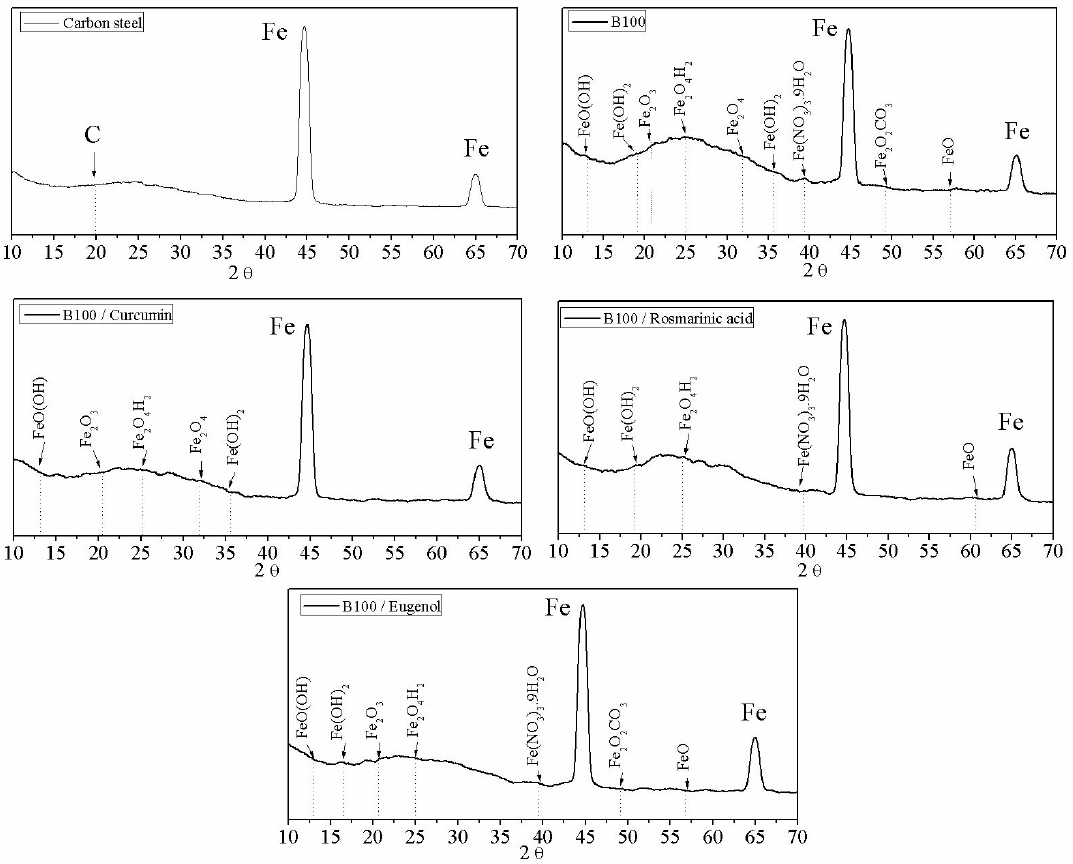
Figure 8. XRD patterns of the carbon steel surface before and after immersion in B100 in the absence and presence of